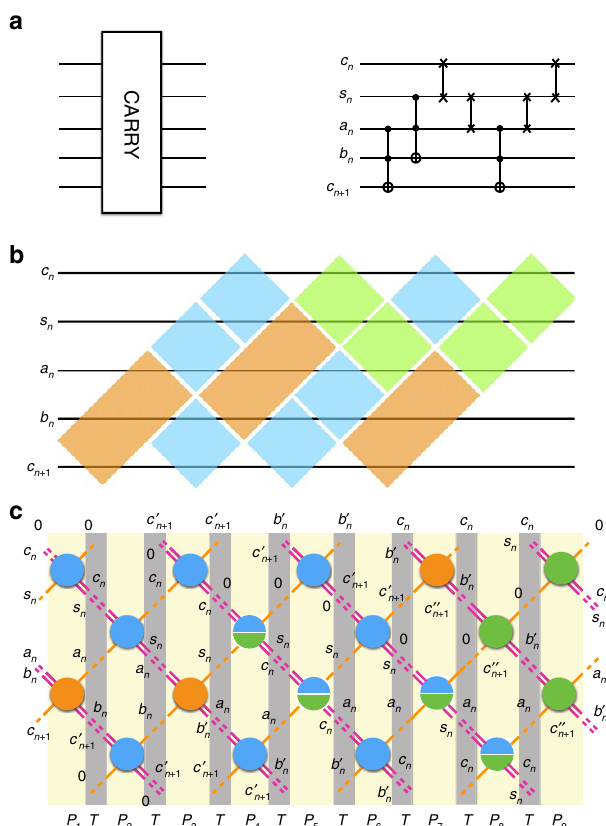
Figure 2 | Tile and vertex model representation of the ripple-carry adder. ( a ) The ripple-carry adder which computes the carry bit that is ‘rippled’ to the next bit. We add one additional control line s n and set it to 1 to implement the original CNOT gate with a TOFFOLI gate. ( b ) The ripple- carry adder implemented on the tile lattice, with different gates depicted in different colours: blue tile: ID; green tile: SWAP; gold tile: TOFFOLI. Spins between adjacent tiles are forced to be equal by the ferromagnetic ‘grout’ coupling K . ( c ) The ripple-carry adder mapped to a vertex model with periodic boundary condition in the transverse direction. After each column of gate (vertex) operation, bit states are labelled at each bond. Light yellow and grey stripes represent the P and T matrices used in the transfer matrix calculation of the partition function.